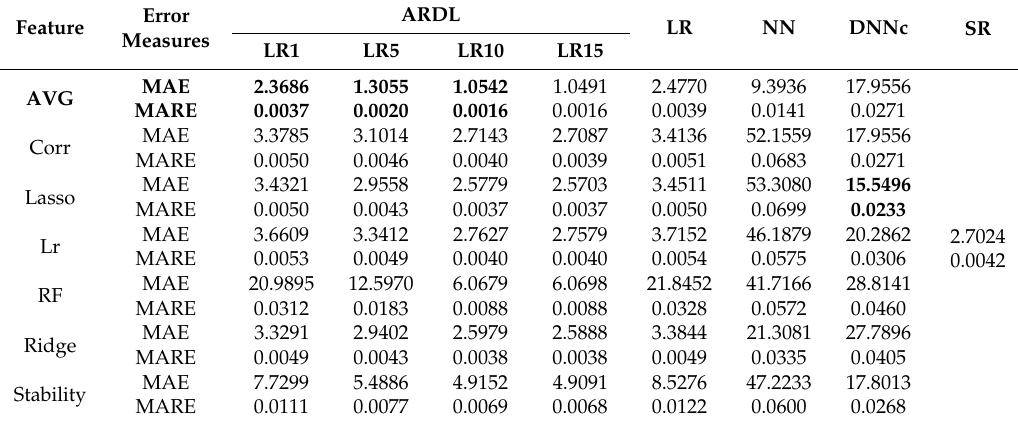
Table 3. Results of models for forecasting the GTCOAT temperature. ARDL: autoregressive distributed lag time series model, DNN: deep neural network, LR1: time-series model with 1 lag, MAE: mean absolute error, MARE: mean average relative error, NN: neural network, SR: stepwise regression.